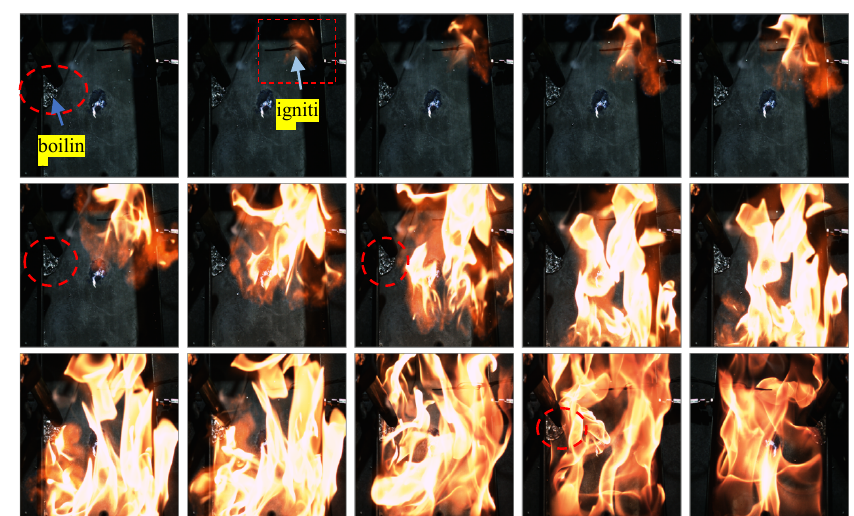
Fig. 3. Ignition spread process of 5 mL jet coal at high temperature hot surface.